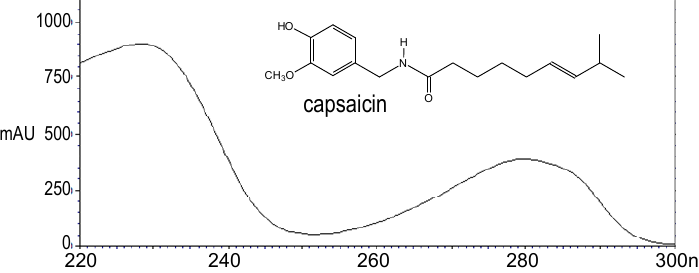
Figure 3. UV spectrum of capsaicin peak eluted at 4.69 mn. The maximum absorbance = 228 nm. corresponds to  max